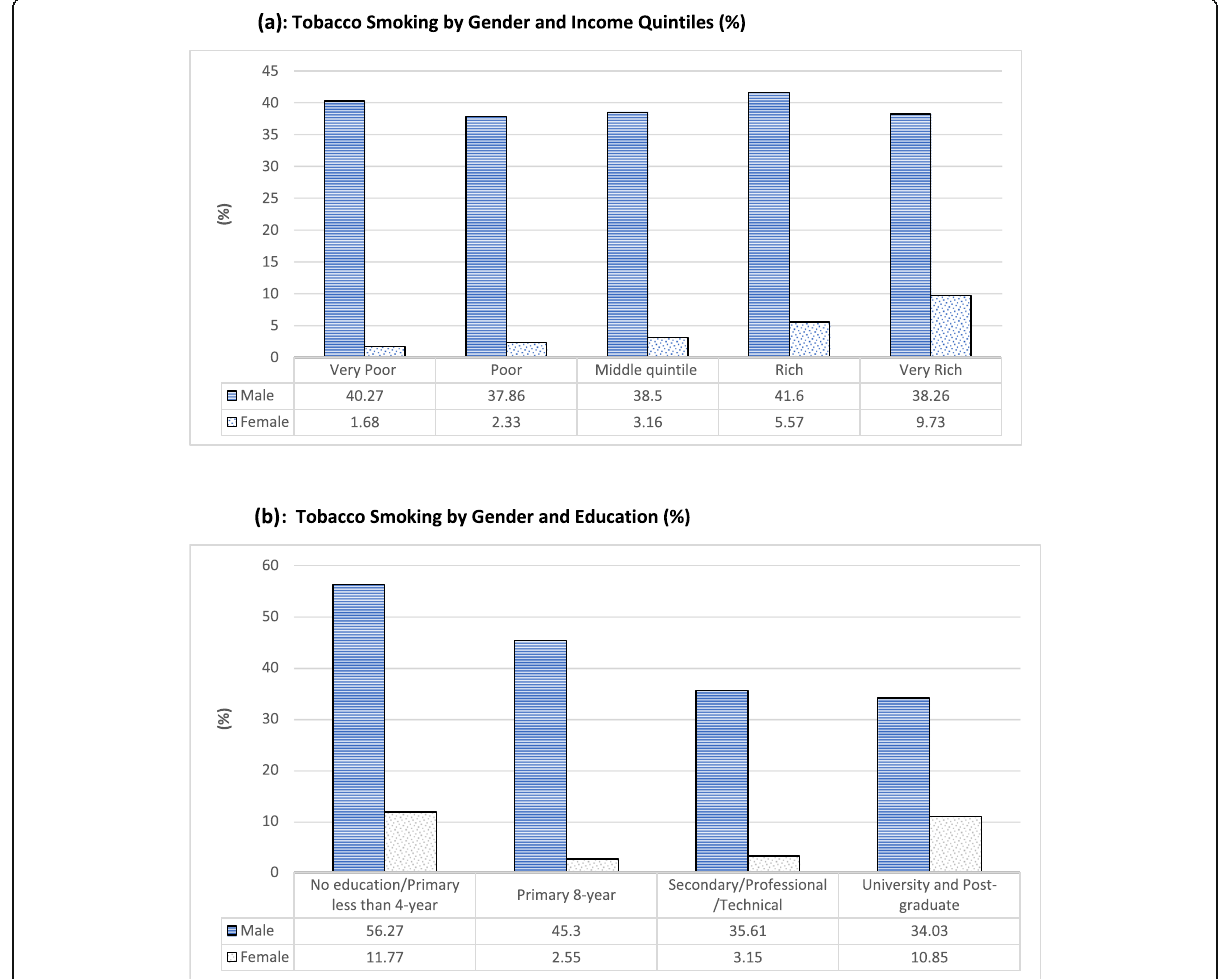
Fig. 2 a Tobacco Smoking by Gender and Income quintiles (%). b Tobacco Smoking by Gender and Education